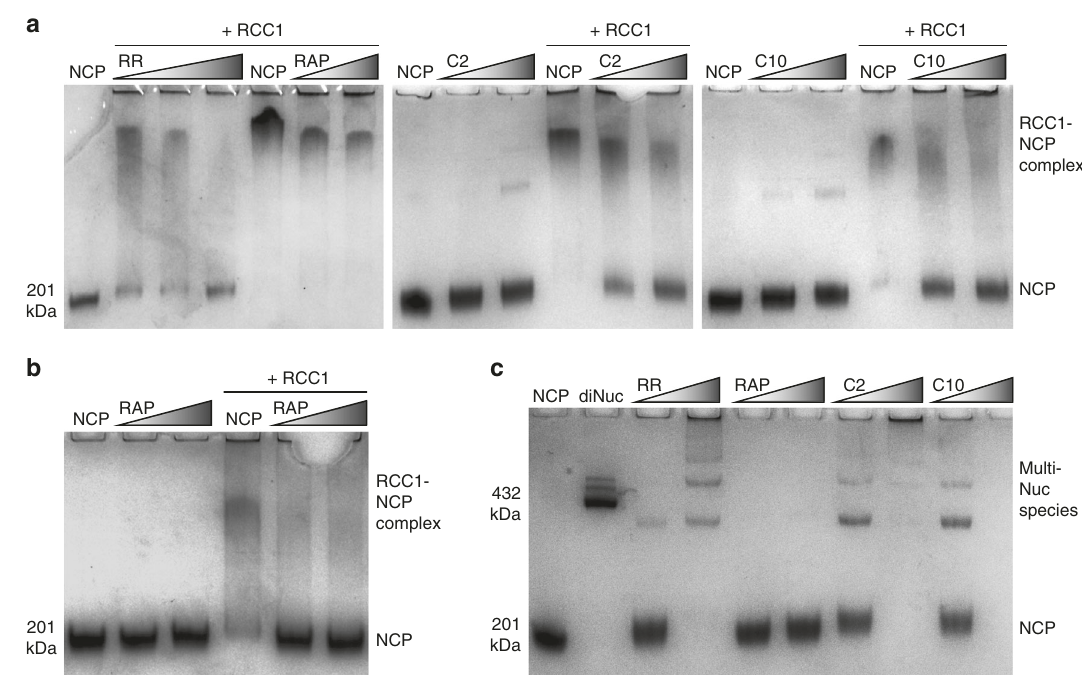
Fig. 8 Nuclear protein binding and inter-nucleosomal cross-linking analysis of agent-treated nuclesosome core particle. a , b Native PAGE RCC1-NCP binding analysis including treated (high-concentration RAPTA-C [RAP] treatment, b ) and untreated (NCP) samples, with and without added RCC1 protein. c Native PAGE NCP-NCP cross-linking analysis, including untreated NCP and dinucleosome (diNuc) samples for reference. Note the higher concentration C10-treated sample is lost to